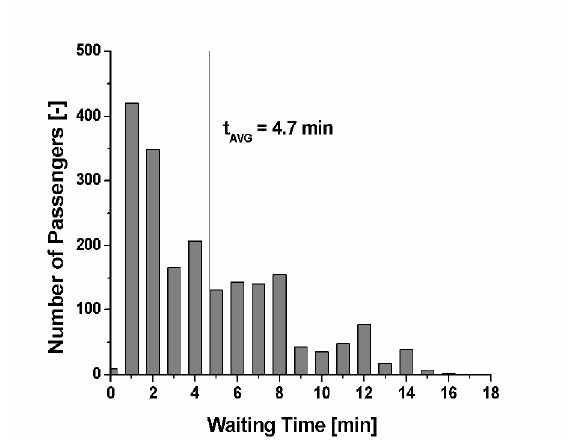
Figure 2: Histogram revealing waiting time frequencies for 2547 cases (passengers) present on a typical working day at the platform. The overall average for the entire pool of passengers counted amounts to 4.7